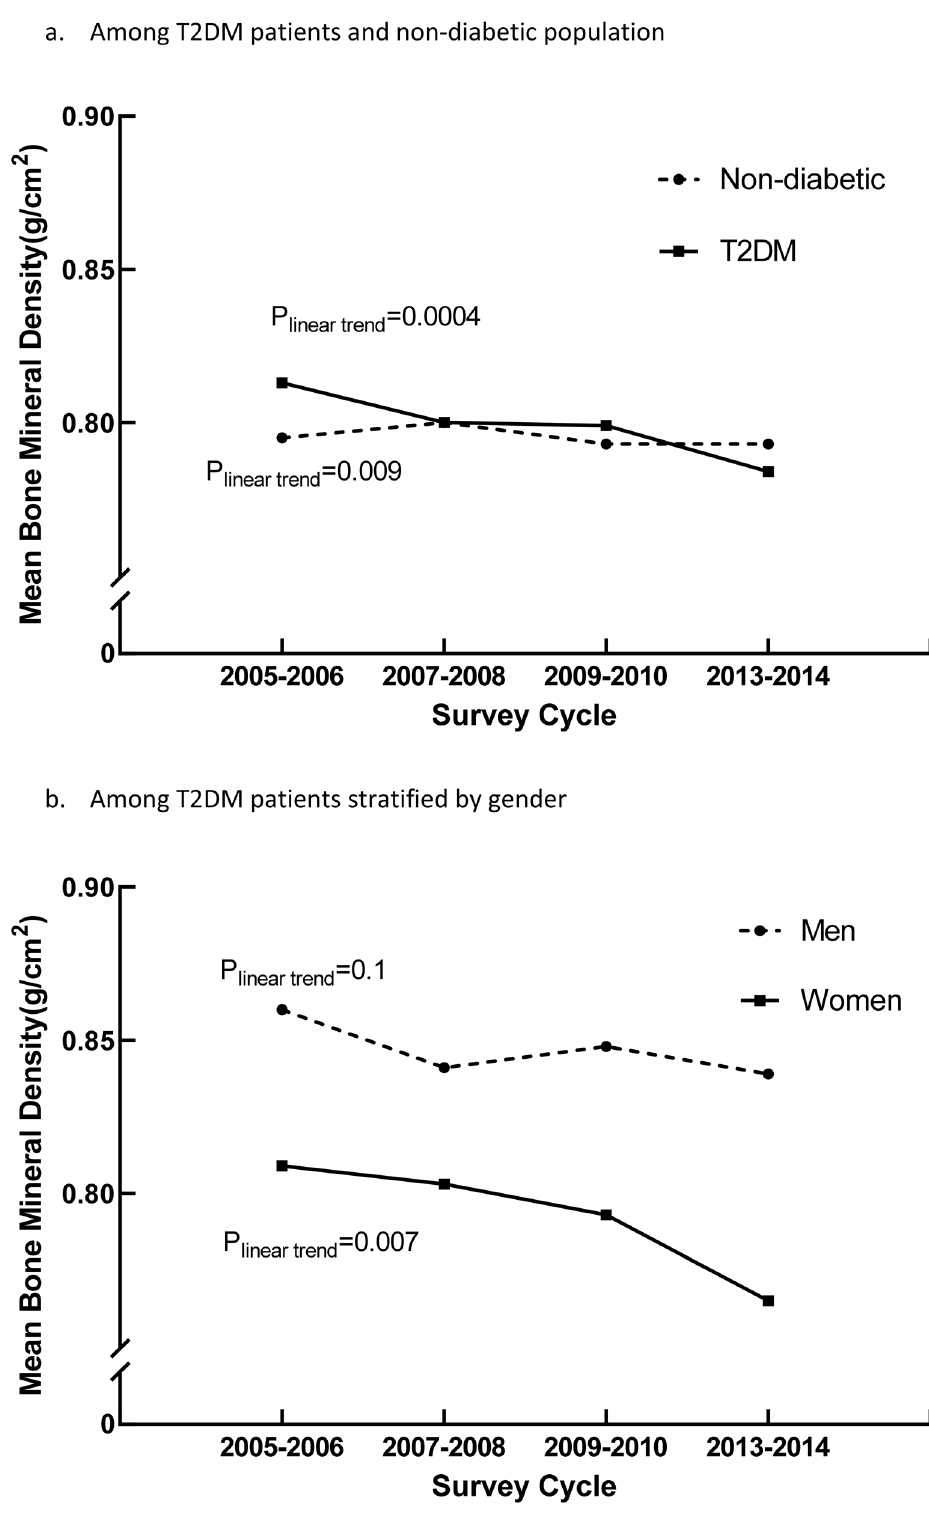
Figure 1. Age and body mass index-adjusted mean bone mineral density in 4 NHANES (2005–2006, 2007– 2008, 2009–2010, and